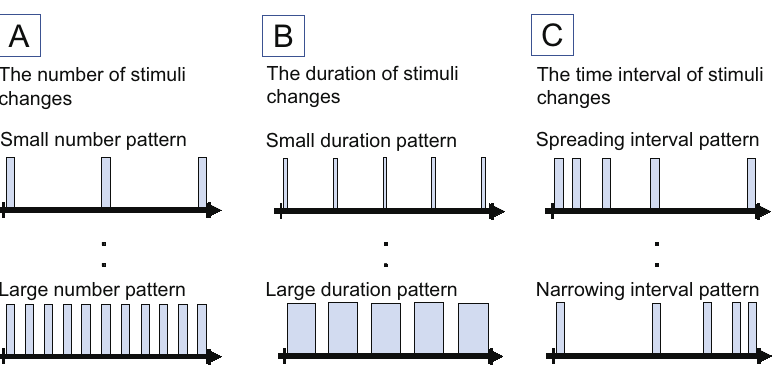
Figure 2. Proposed methods of presenting tactile stimuli. ( A ) is a method that changes the number of the stimuli. ( B ) is a method that changes the duration of the stimuli. ( C ) is a method that changes the time interval of the stimuli. Reprinted/adapted with permission from Ref. [11] 2021, ACM.